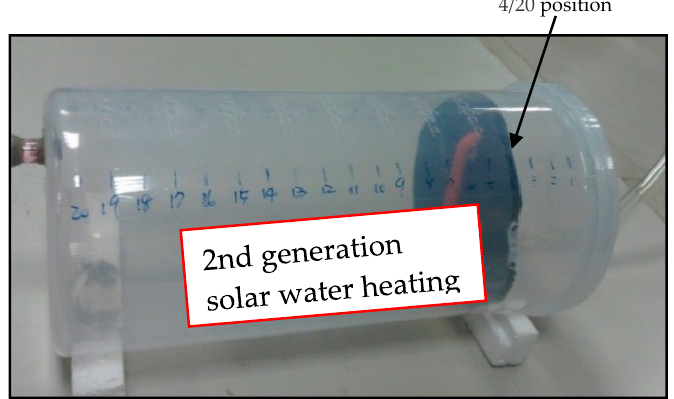
Figure 10. Photo of “fixed dividing disk” of the 2nd generation solar water heating tank model.